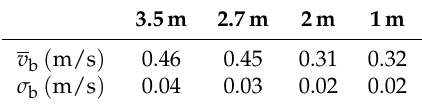
Table 1. Average benchmark velocities ( v b ) and standard deviations ( σ b ) measured with the current meter in the Brenta River. Measurement locations are at 1, 2, 2.7, and 3.5 from the right-side river